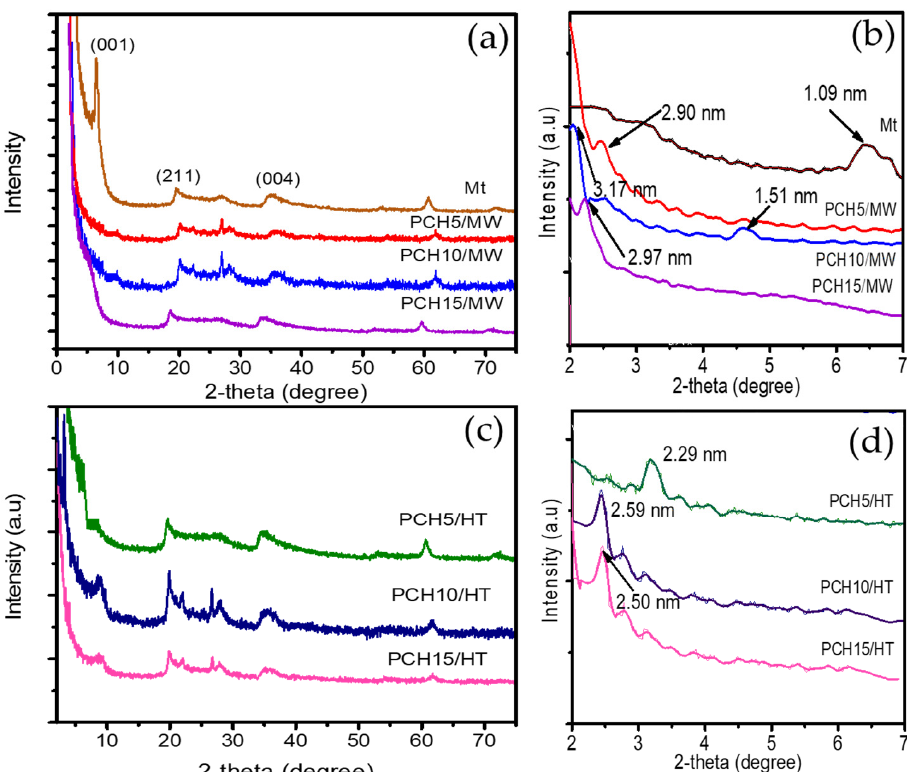
Figure 2. XRD and small angle XRD patterns of ZnO 2 /SiO 2 ‐ PCH synthesized by ( a , b ) MW method ( c , d ) HT method.